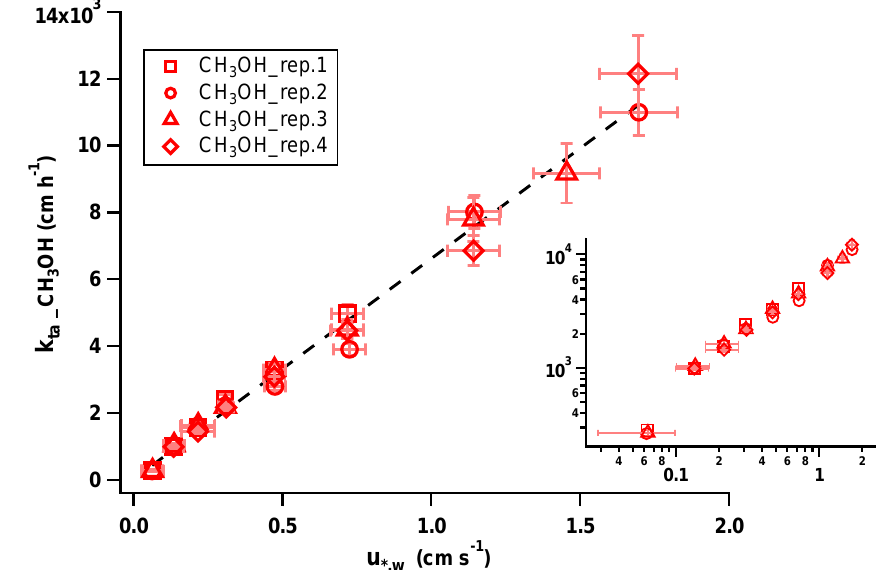
Figure 8. Total transfer velocity of CH 3 OH of four clean case repetitions plotted against u ∗ , w . Symbols and bars are the same as in Fig. 7.